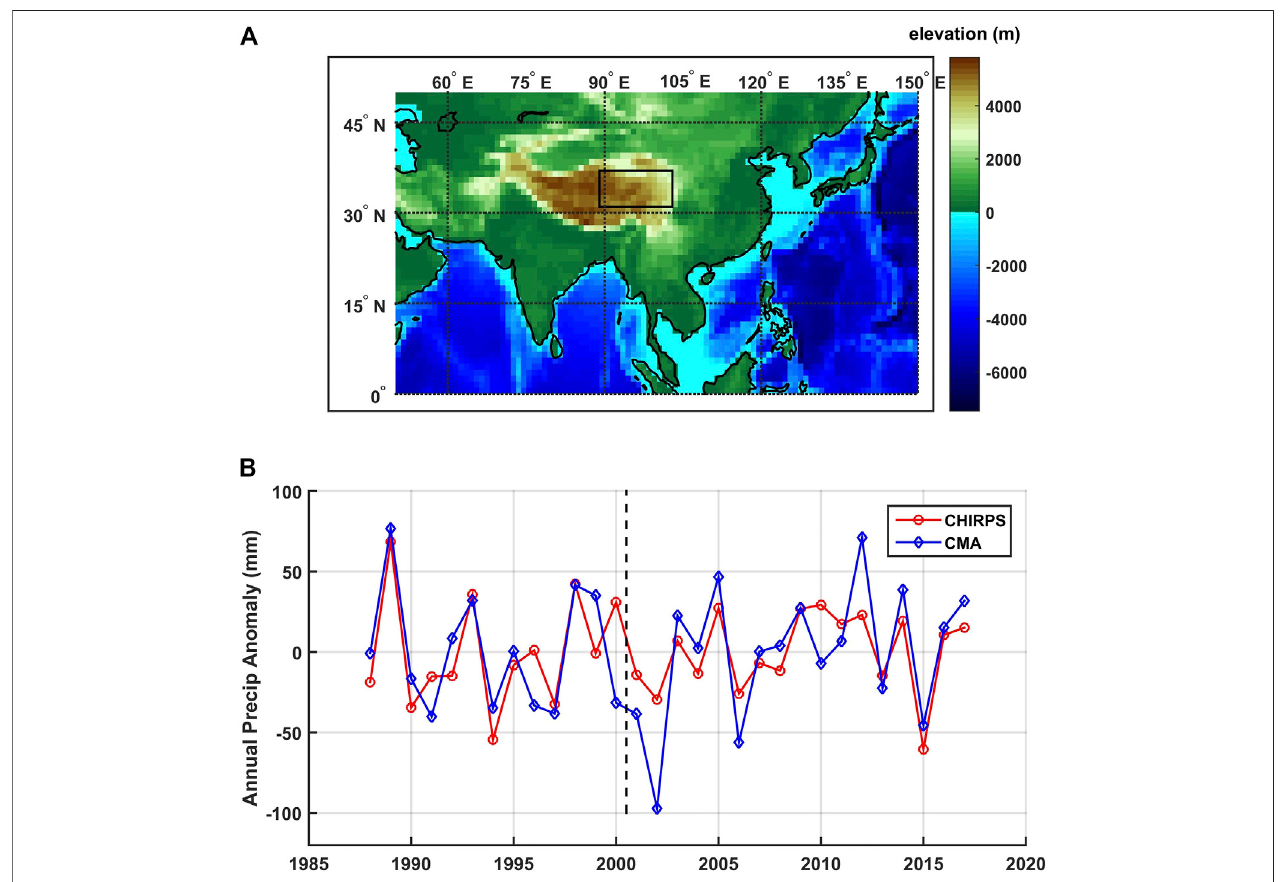
FIGURE1|(A) ThestudyregionofTRHR(blackbox)asplottedinanelevationmapbasedonETOPO-5(Center,1988)and (B) timeseriesofthespatiallyaveraged precipitation from CHIRPS (red) and CMA (blue) after standardization.